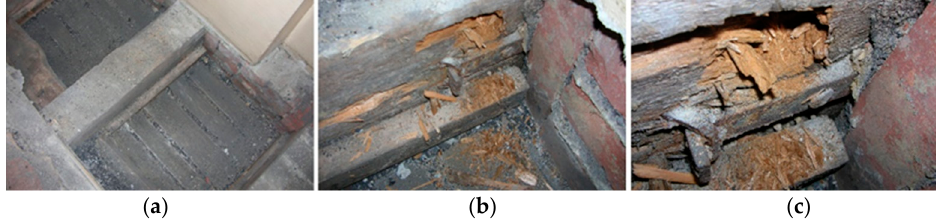
Figure 3. Examples of a damaged floor in the support and buttress zones: ( a ) no externally visible damage, ( b , c ) advanced brown decay of wood inside the same beam.